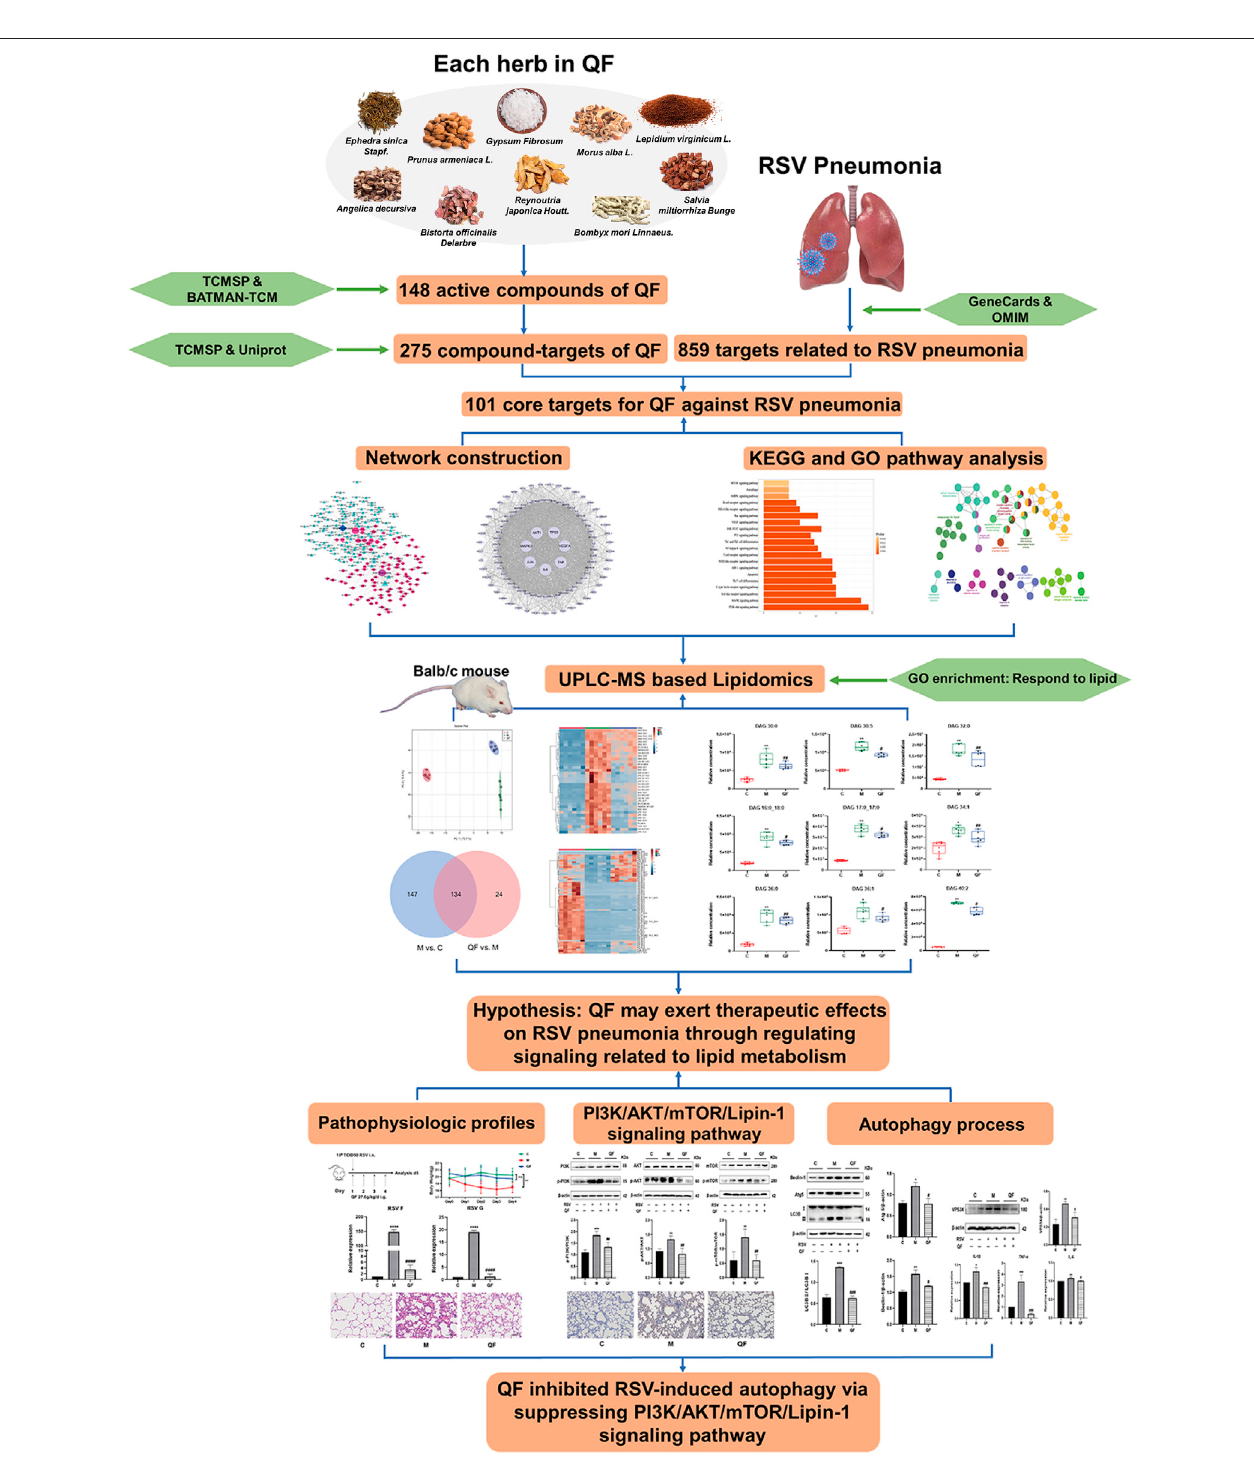
FIGURE 1 | Study design. Abbreviations: QF, Qingfei oral liquid; RSV, respiratory syncytial virus.